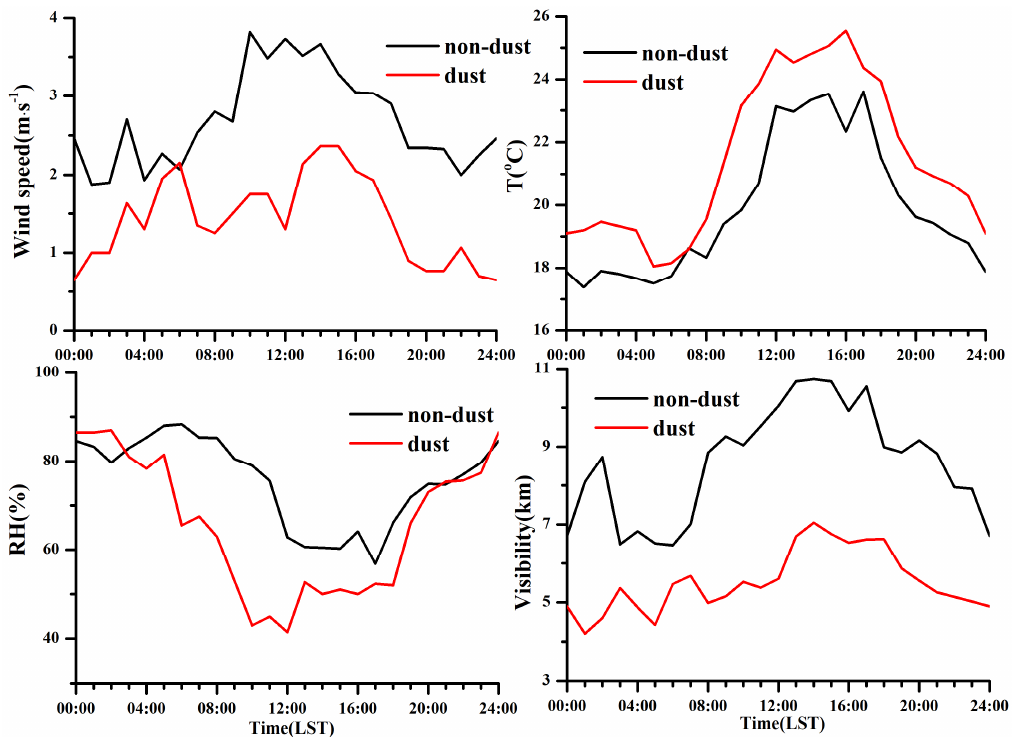
Figure 4. Diurnal variations of meteorological elements during the dust and non-dust episodes.